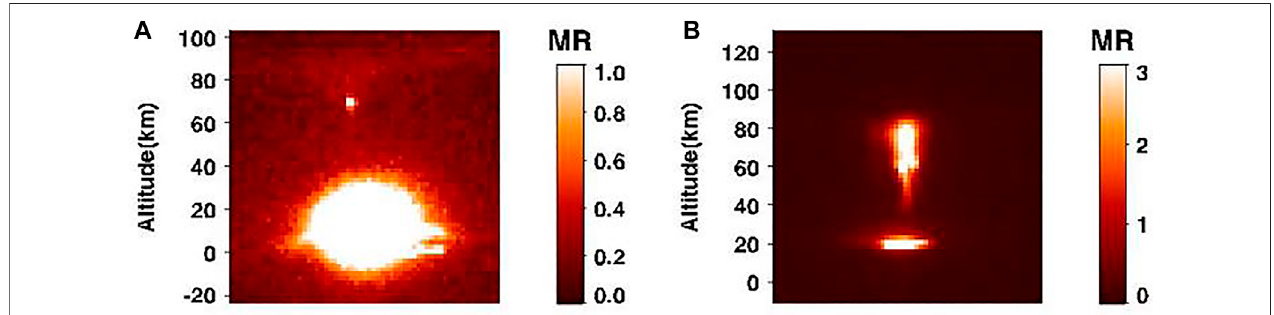
FIGURE5| TwodistincttypesofobservedspritesdeterminedbytheAPwherethecolorindicatesthebrightnessinunitsofMR(megaRayleigh): (A) thespritehalo event observed at 14:53:13.687 – 716 on October 3, 2005 where the upper part (70 – 90 km) was a funnel-shaped halo structure with a compact sprite emission at ∼ 70 km, and the lower part (0 – 40 km) was a nut-shaped lightning emission fi lled with scattered photons (Luque et al., 2020), and (B) the carrot sprite event at 04:36: 16.235(UT)onJuly11,2010.Thecarrotspriteemissionextendedwidelyataltitudesof30 – 90 kmoverthecloudtopemissionataprojectedaltitudeupto ∼ 20 km.